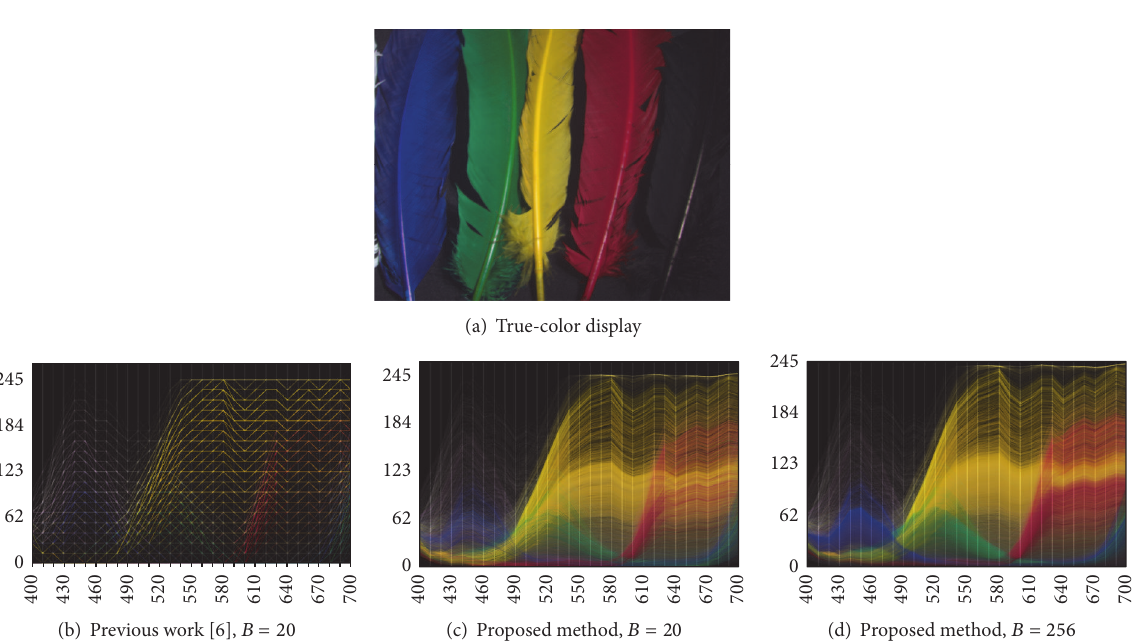
Figure 3: Spectral distribution view of cropped feathers image with different bin parameters. Spectra in true